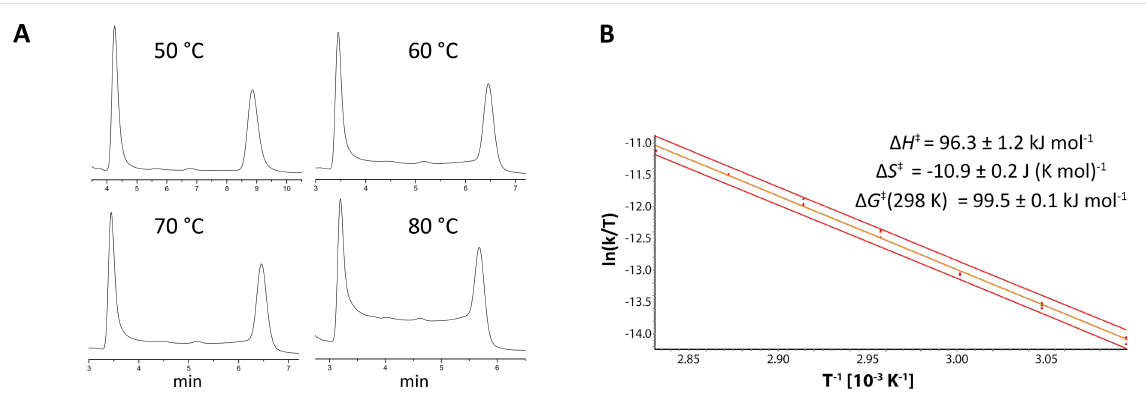
subsequent Eyring plot analysis gave the activation parameters Δ H ‡ = 68.4 ± 1.9 kJ mol − 1 and Δ S ‡ = − 79.9 ± 4.5 J (K mol) − 1